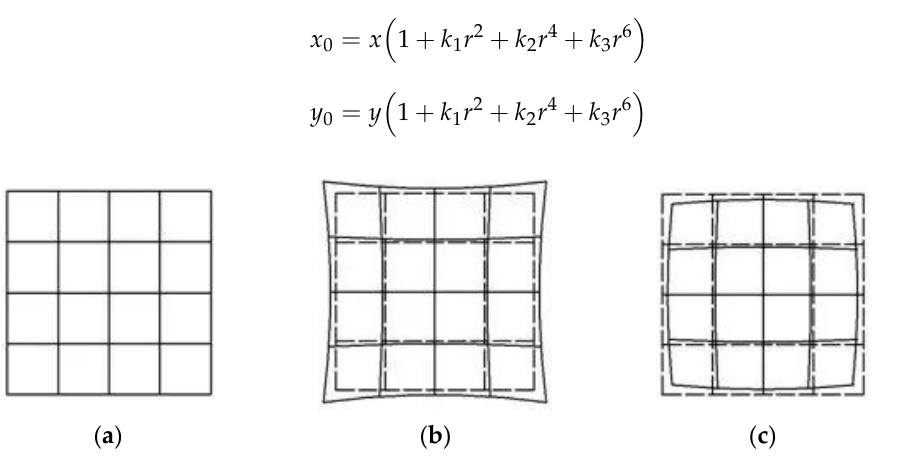
Figure 1. ( a ) No distortion; ( b ) pincushion distortion; ( c ) barrel distortion.